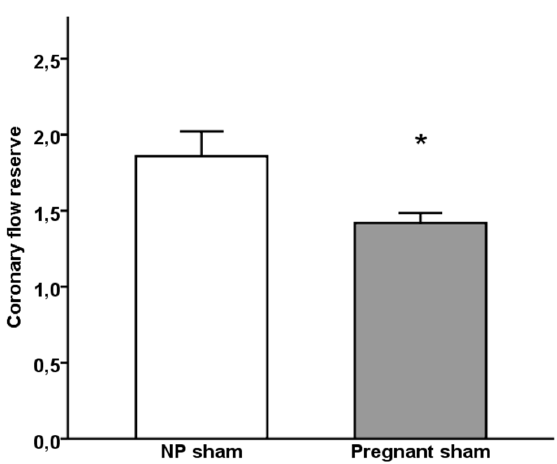
Figure 3. Coronary flow reserve in sham rats. Mean 6 SEM for coronary flow reserve calculated from peak velocities in non-pregnant (NP) and pregnant sham animals from both studies. Independent- Samples T-test was used to compare groups. SEM, standard error of the mean, NP, non-pregnant, p , 0.05 compared to non-pregnant sham (*).